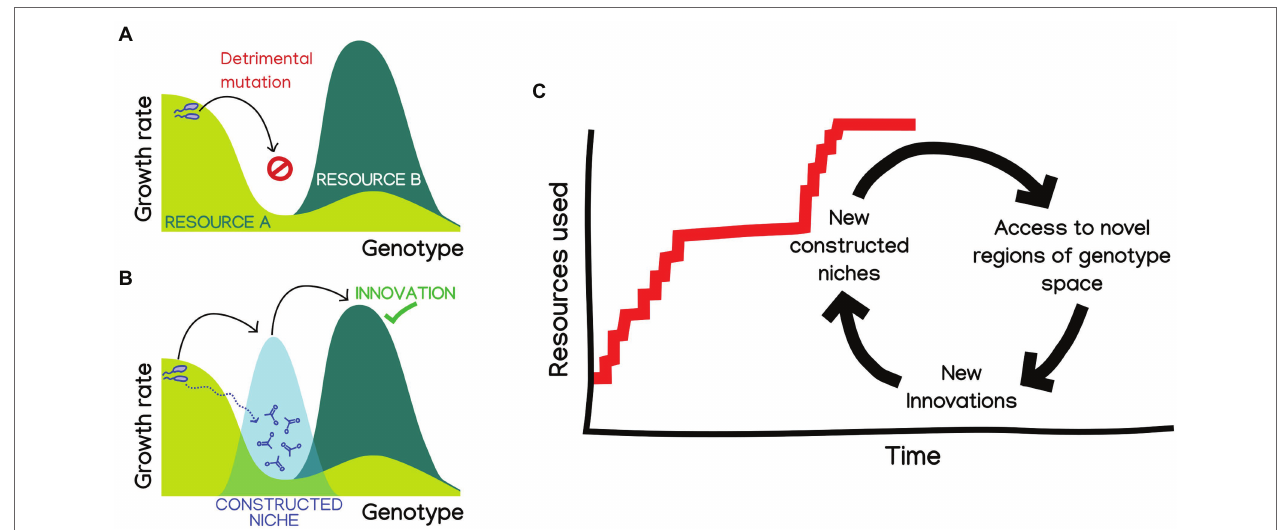
FIGURE 1 | Niche construction could facilitate metabolic innovation and adaptive radiation in microbes. (A) Complex innovations, requiring two or more mutations, are hard to reach through adaptive evolution, needing the fixation of neutral or deleterious mutations. (B) Niche construction could provide “bridge”